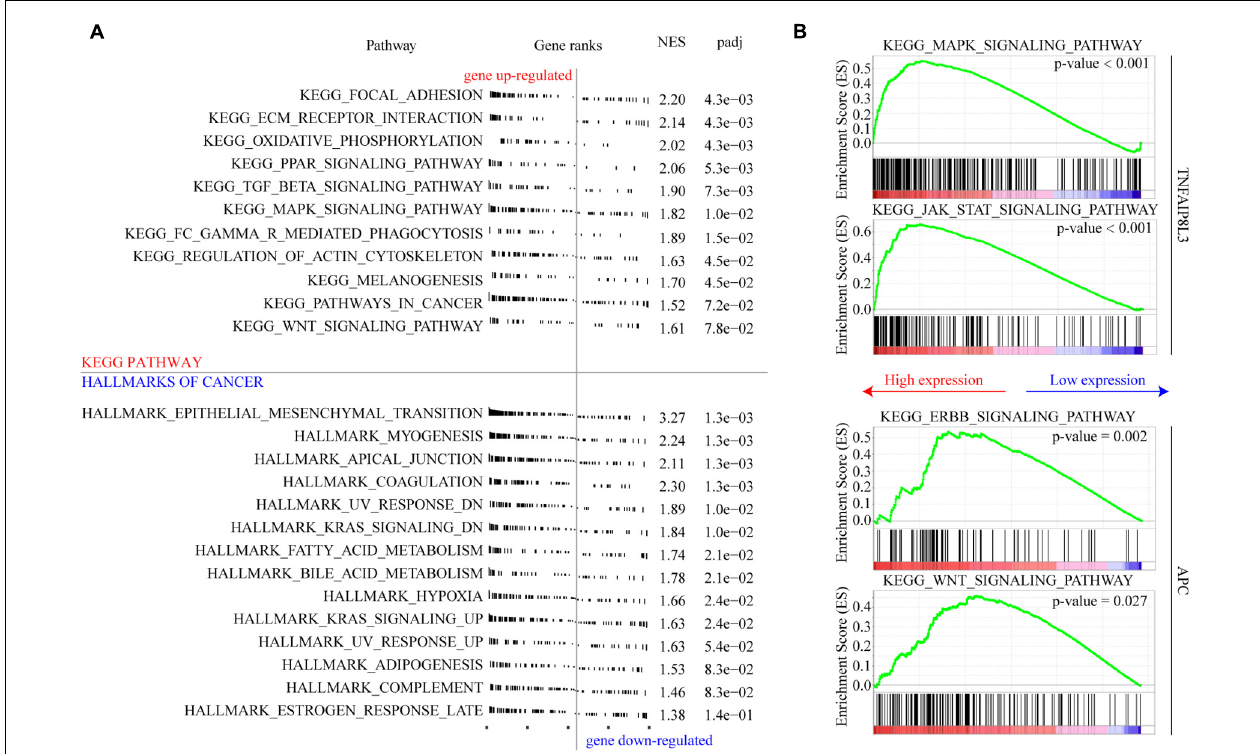
FIGURE 8 | Cellular pathways/processes affected by MRSB methylation model. (A) Gene Set Enrichment Analysis showing the signature in the context of gene sets representative for Kyoto Encyclopedia of Genes and Genomes (KEGG) pathway and cellular process from hallmarks of cancer. (B) MAPK signaling pathway and JAK-STAT signaling pathway were significantly enriched in TNFAIP8L3 overexpression cases. ERBB signaling pathway and WNT signaling pathway were enriched in APC overexpression cases. MRSB, methylation risk score for bladder